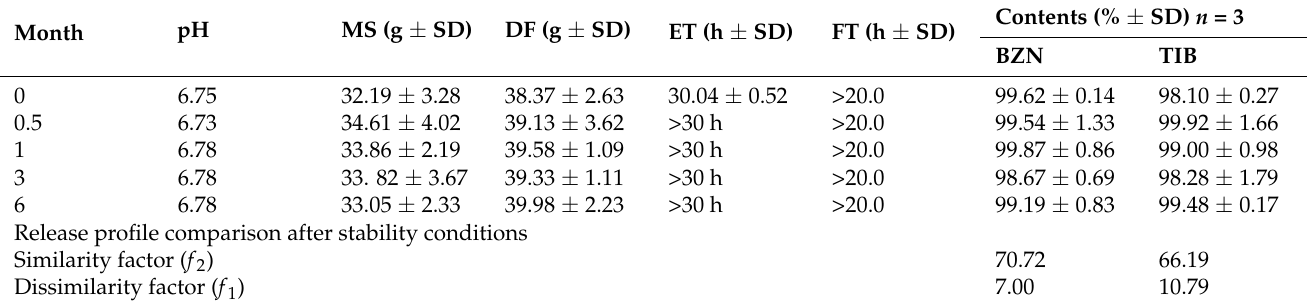
Table 6. Response of the optimized formulation to the stability test.